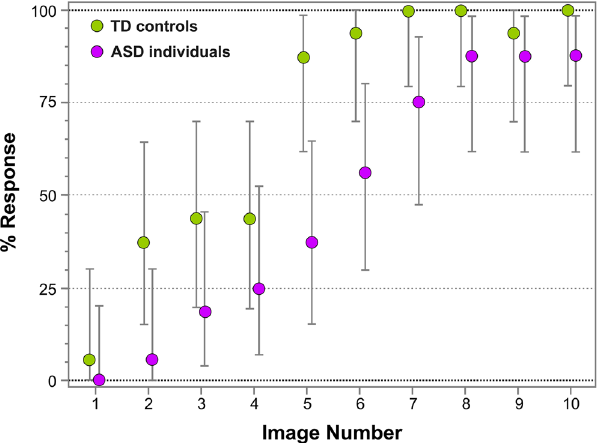
Figure 4. Percentage of face responses for ASD individuals and TD controls. The image number reflects its face resemblance (1 – the least recognizable, 10 – the most recognizable as a face). Vertical bars represent 95% CI.